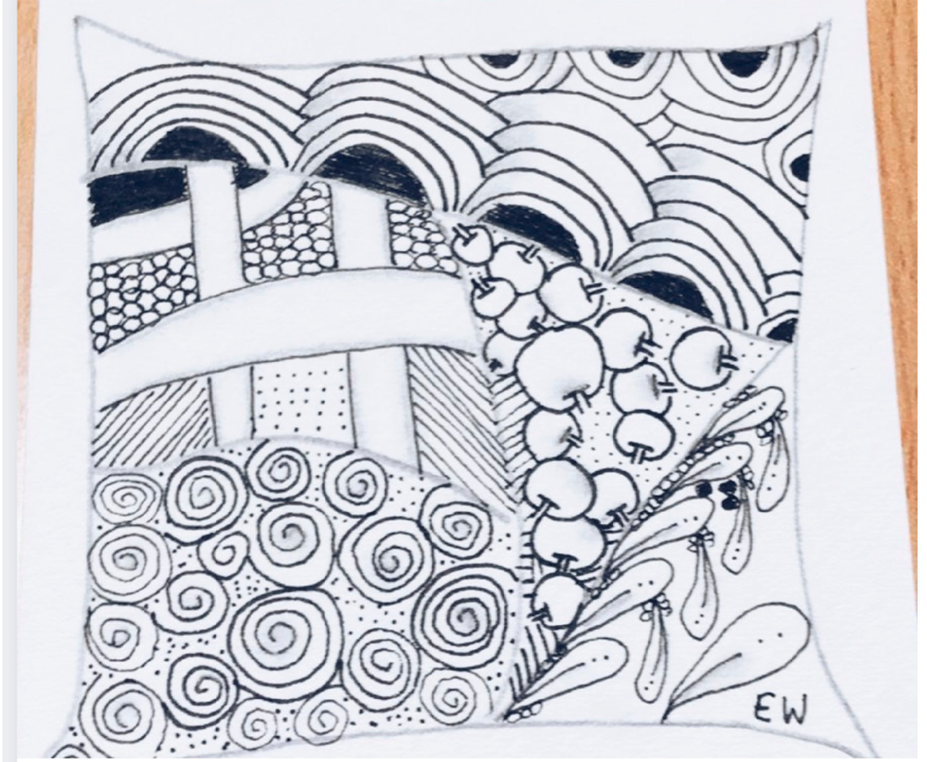
Figure A1. Sample Zentangle artwork created in one workshop (five patterns, left bottom to top right: printemps, hollibaugh, pokeroot, flux, and crescent moon).